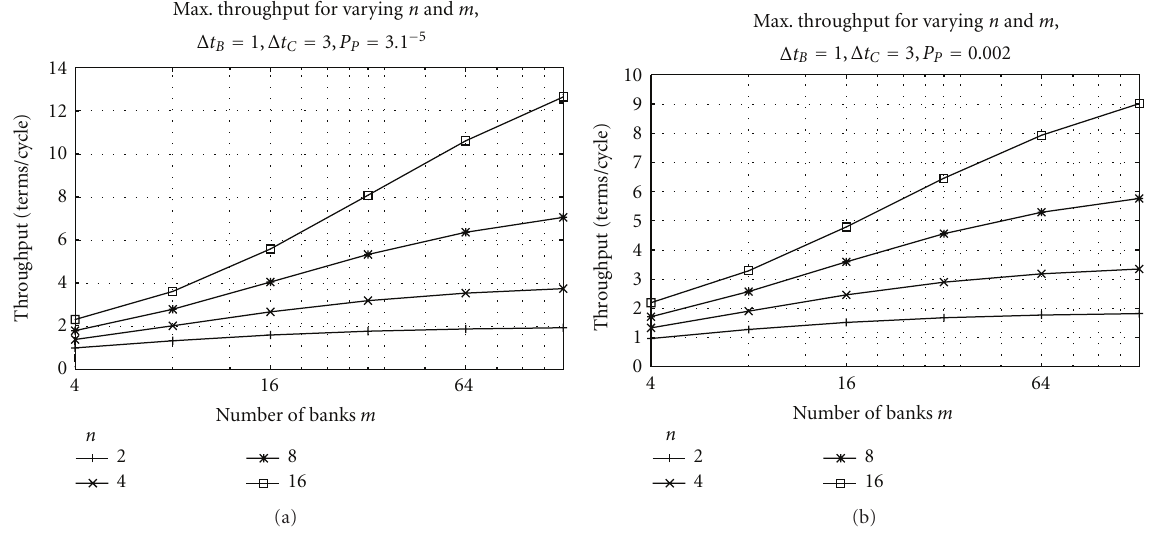
Figure 8: Average access time for a Bloom filter with m banks and n access ports, Δ t S = 20, (a) P P = 3 · 10 − 5 (b) P P = 0 . 002.